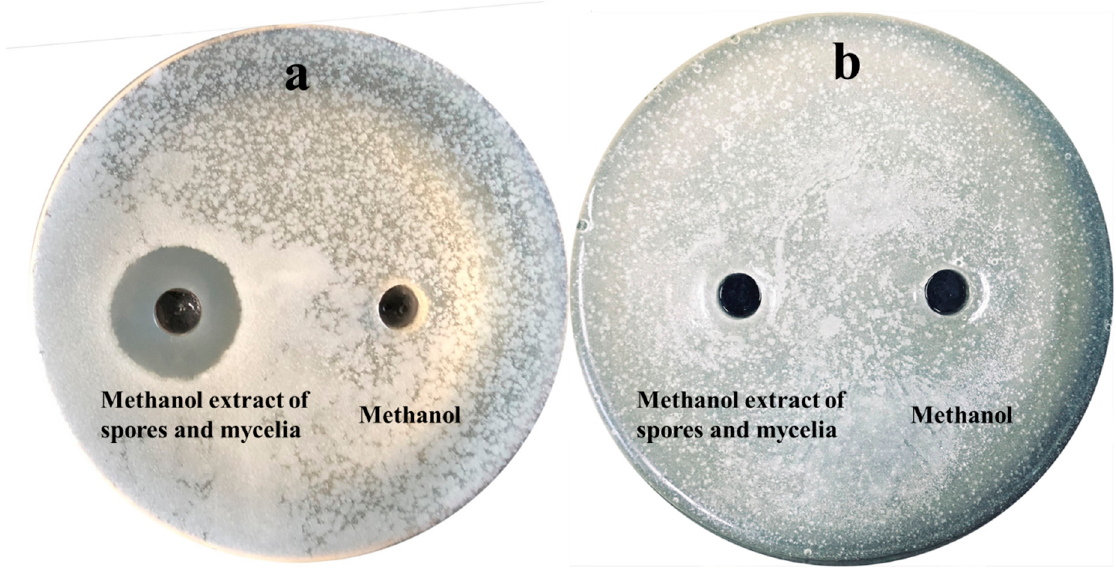
Figure 4. The antibacterial activity of strain NEAU-SSA 1 T against Ralstonia solanacearum ( a ) and Micrococcus luteus ( b ).